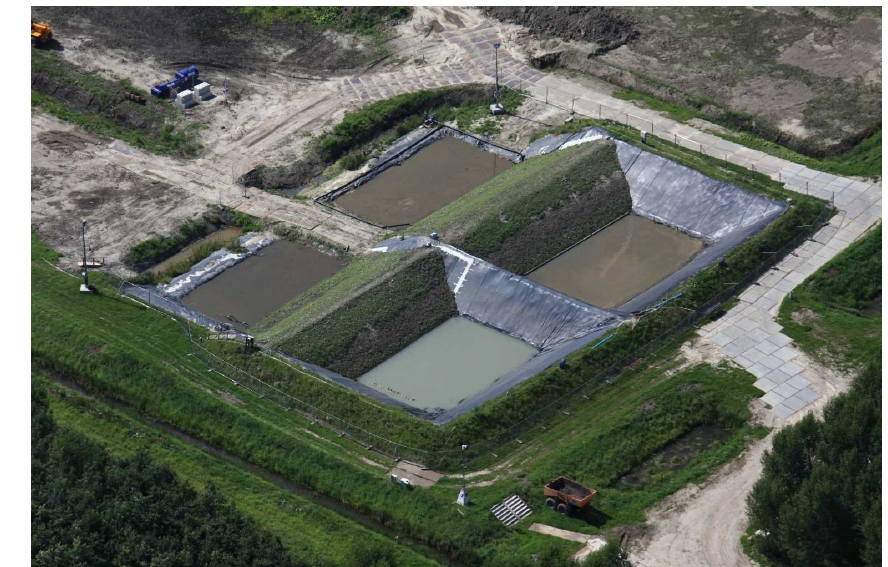
Figure 2. Large-scale piping